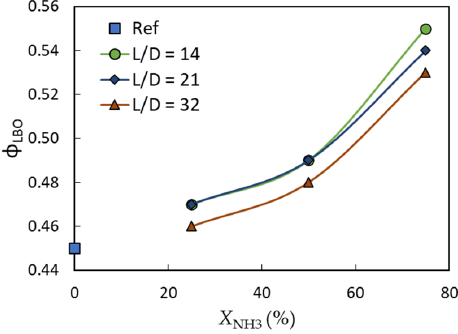
Figure 2. Measured equivalence ratios at lean blow ‐ off limits as a function of ammonia volume fractions for different mixing lengths. fractions for different mixing